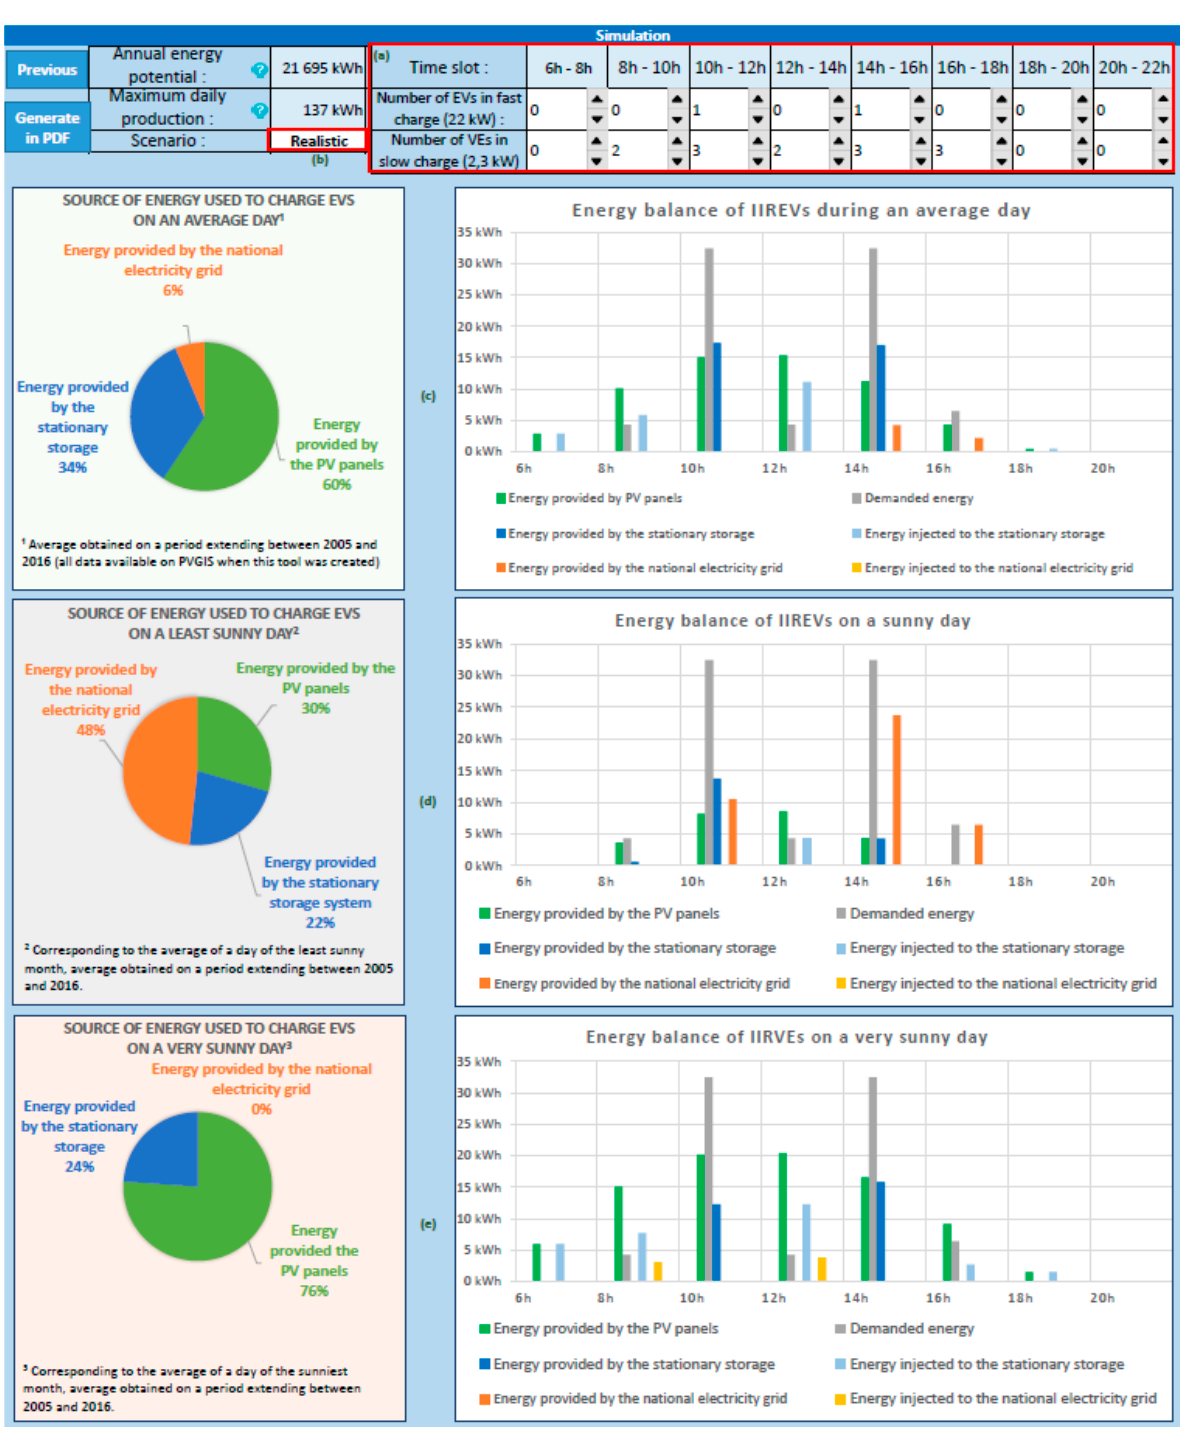
Figure 7. Interface for PVCS energy: realistic scenario ( a ), number and type of terminals occupied per time slot ( b ), results for average sunny day ( c ), results for poorly sunny day ( d ), and results for very sunny day ( e